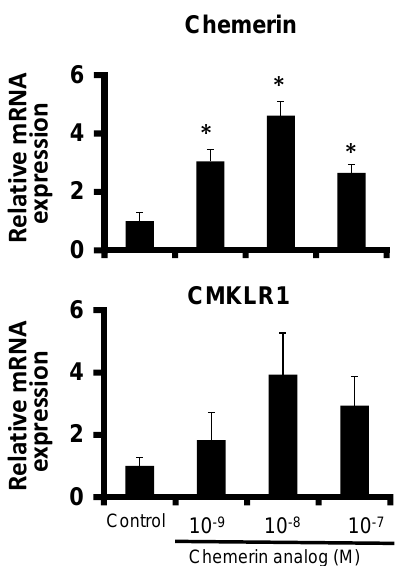
Figure 3. Gene expression levels of chemerin and CMKLR1 in bovine differentiated adipocytes treated with chemerin analog (10 -9 , 10 -8 and 10 -7 M). The data are shown as means  SEM and represent data collected from at least three experiments. The data were normalized with 18s rRNA and shown as means  SEM in relative to the levels of control cells (* p<0.05 vs